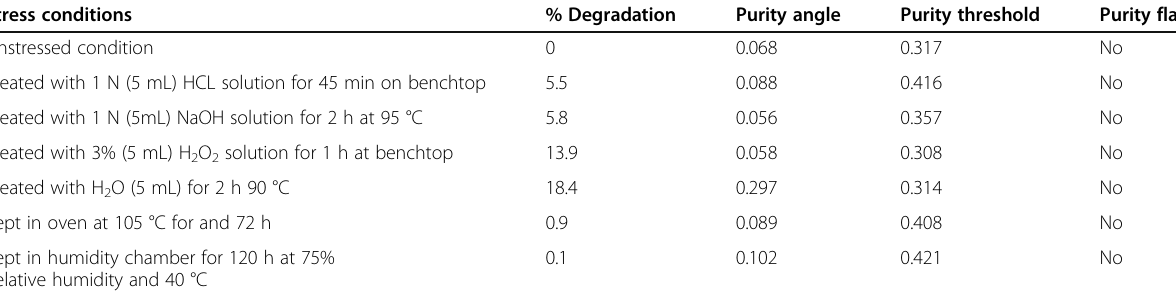
Table 1 Forced degradation study results Stress